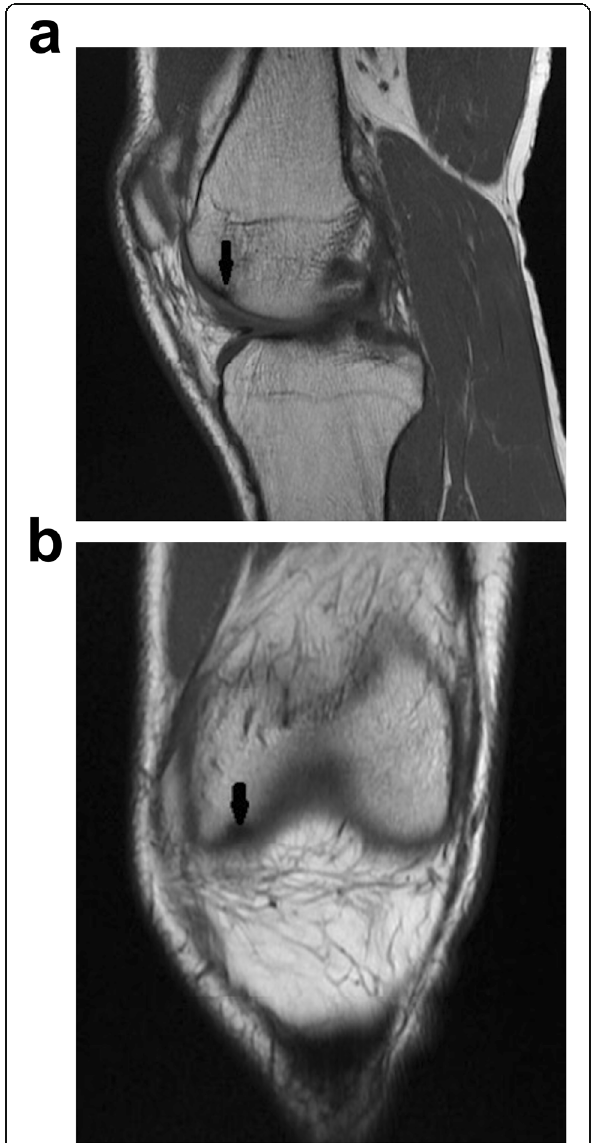
Fig. 2 Left Knee T1 MRI showing subtle abnormality of subchondral bone in the same patient. a Sagittal view, b Coronal